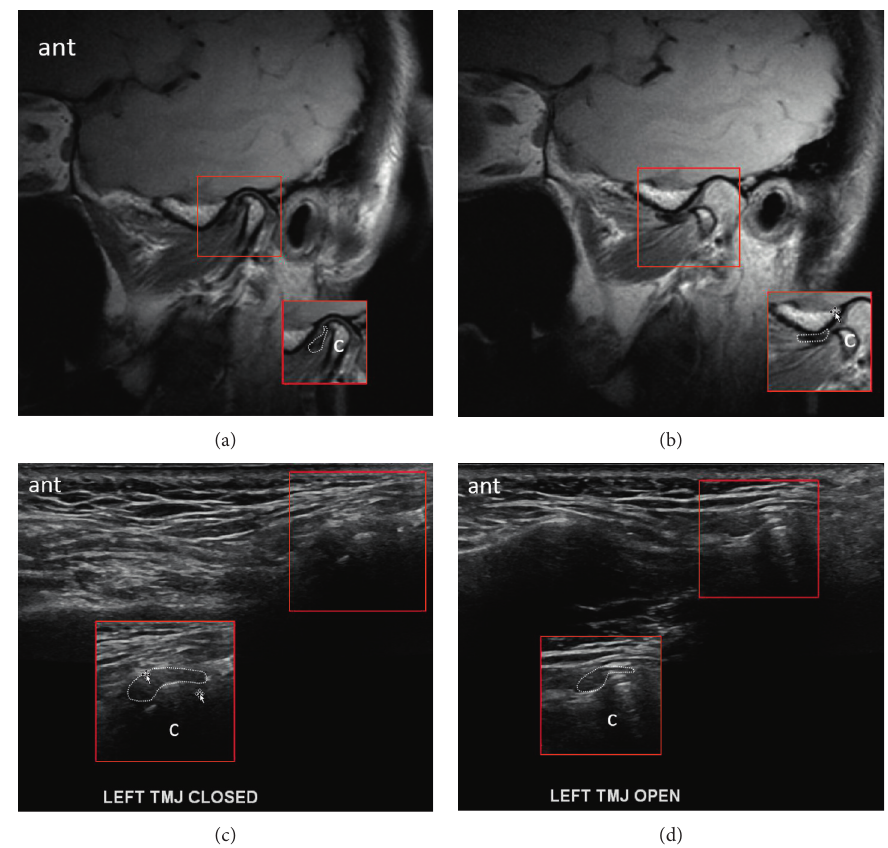
Figure 5: Images demonstrating a deformed disc with fixed anterior dislocation in the sagittal plane in the (a) closed-mouth position with MRI, (b) open-mouth position with MRI, (c) closed-mouth position with US, and (d) open-mouth position with US. A focal annotated view was provided to aid visualization with the articular disc outlined with a dotted contour; condyle � “c”; anterior � “ant”; left �